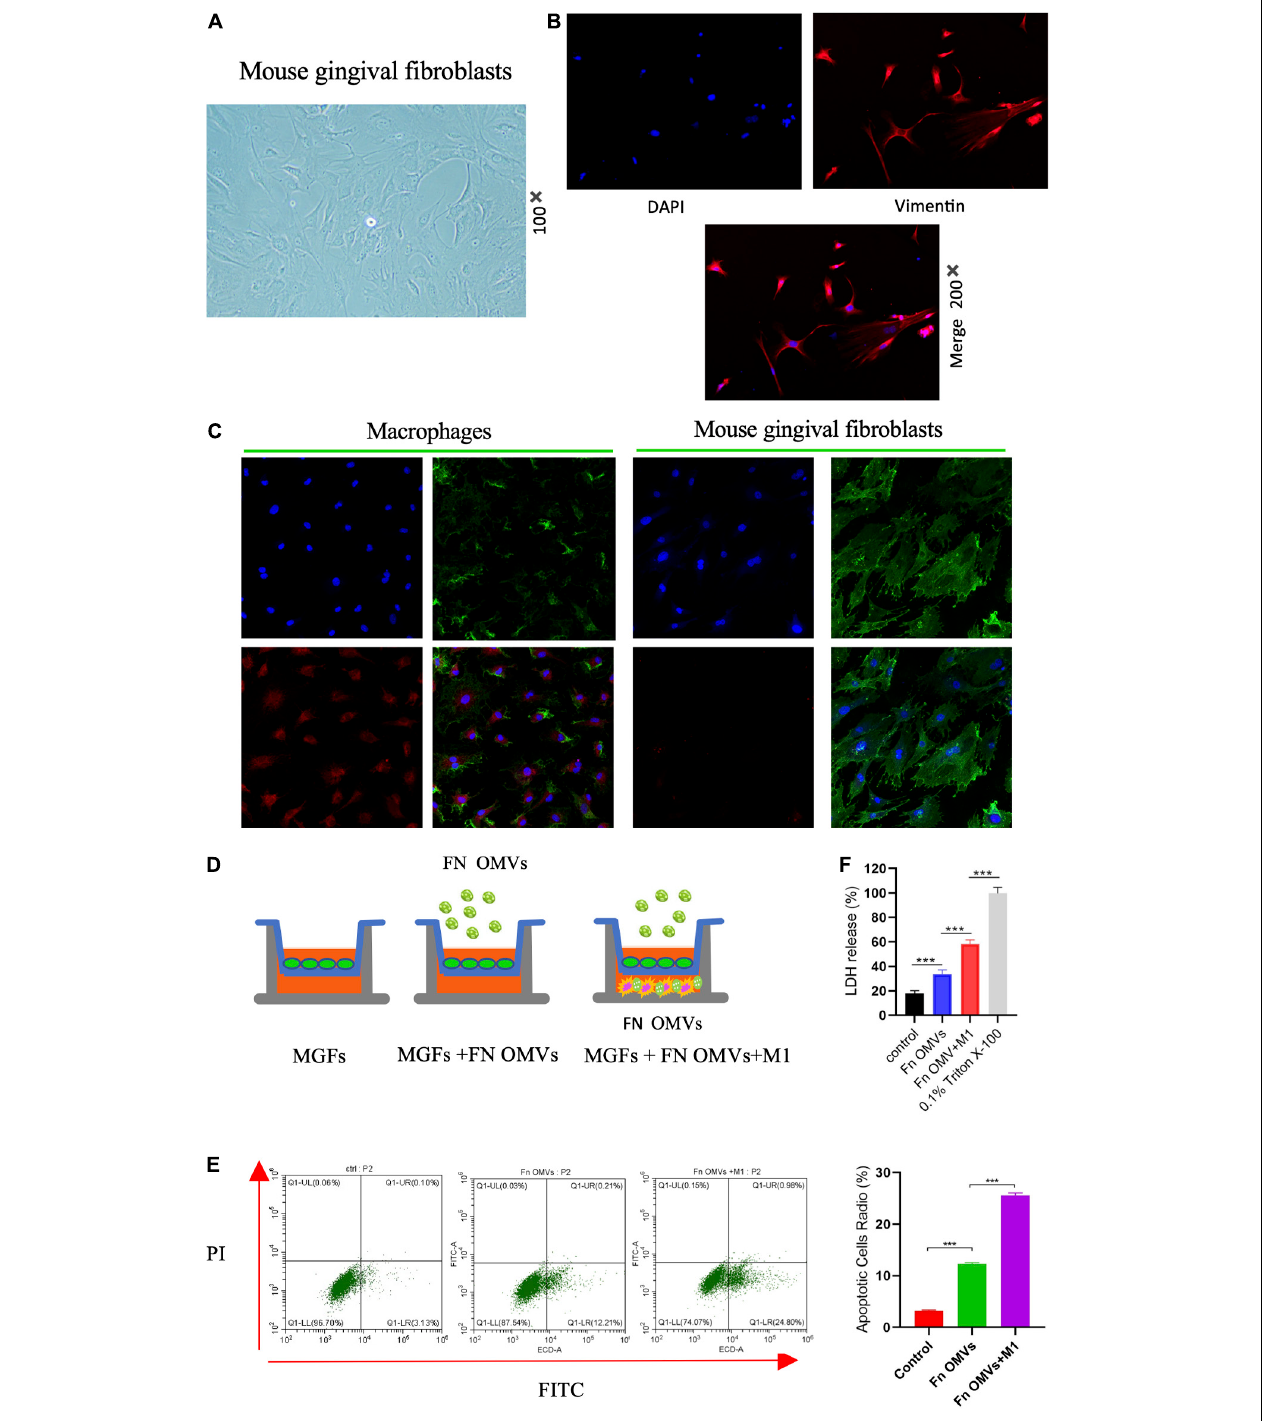
FIGURE 3 | Fusobacterium nucleatum OMVs and M1 macrophages induce MGF death in the proinflammatory microenvironment. (A) MGFs were cultured, and they exhibited a slender, fibrous morphology (100 × ). (B) Vimentin was expressed at high levels in the cytoplasm. (C) Confocal microscopy showed that macrophages engulfed numerous F. nucleatum OMVs within 12 h, while almost no F. nucleatum OMVs were observed in MGFs within 24 h.(Blue: cell nucleus; Green: cell membrane; Red, Fn OMVs). (D) The macrophage/MGF coculture model simulated the interaction between macrophages and F. nucleatum OMVs in vivo . (E) Flow cytometry showed that F. nucleatum OMVs alone increased the apoptosis of MGFs after 24 h of treatment. F. nucleatum OMVs and M1 macrophage treatment induced more severe apoptosis than that observed in the control group. (F) F. nucleatum OMVs stimulated the secretion of LDH by MGFs. F. nucleatum OMVs and M1 macrophages in combination further exacerbated the release of LDH in MGFs. 0.1% Triton X-100 was used as positive control. * P < 0.05, ** P < 0.01, *** P < 0.001.